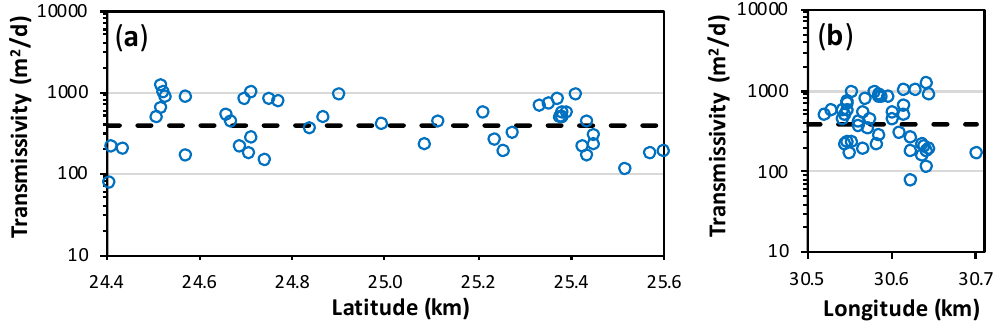
Figure 5. Transmissivity plotted against latitude ( a ) and against longitude ( b ); the dashed line represents the geometric mean transmissivity value of 385 m 2 /d.